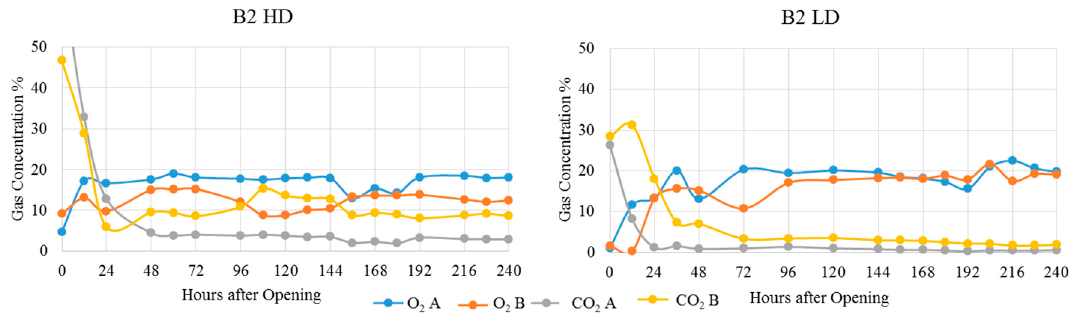
Figure 6. Means of gas concentrations of samples taken from buckets of treatment B2 at two sampling points (A and B); B2 = silage treated with biological inoculant 2, HD = high density, LD = low density.